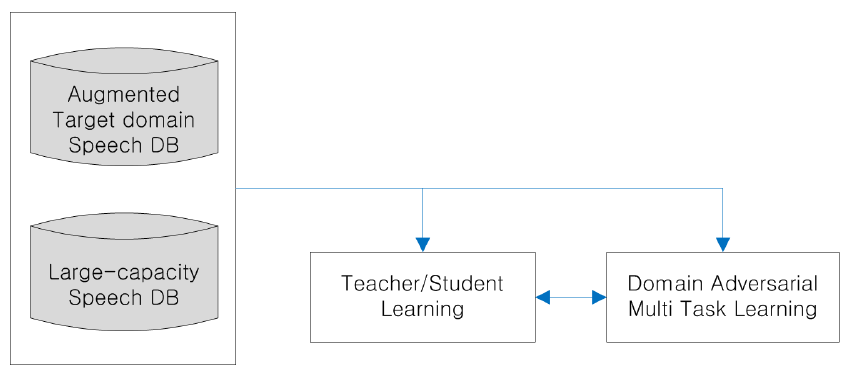
Figure 5. Graphic illustration of the proposed teacher/student learning method.